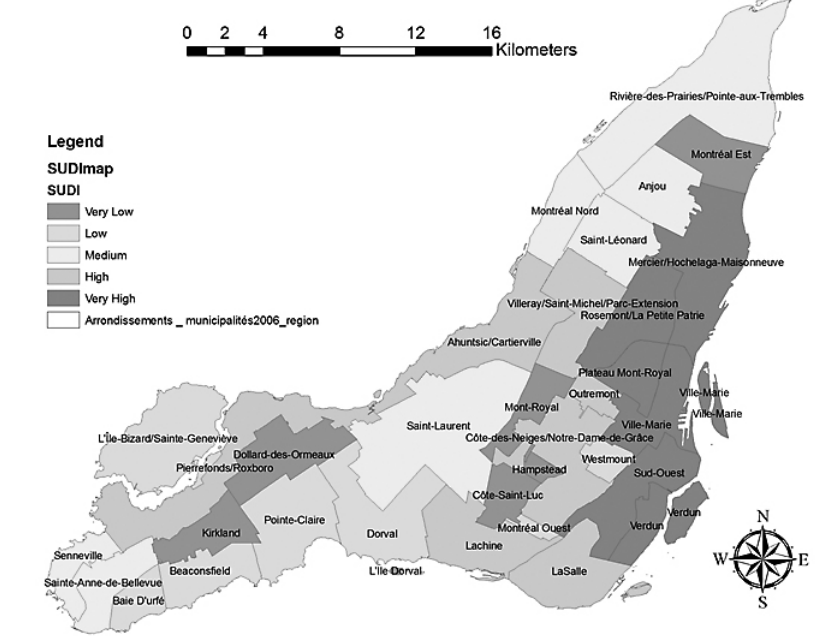
fig. 3. Sustainable urban development indicators for the Montreal urban